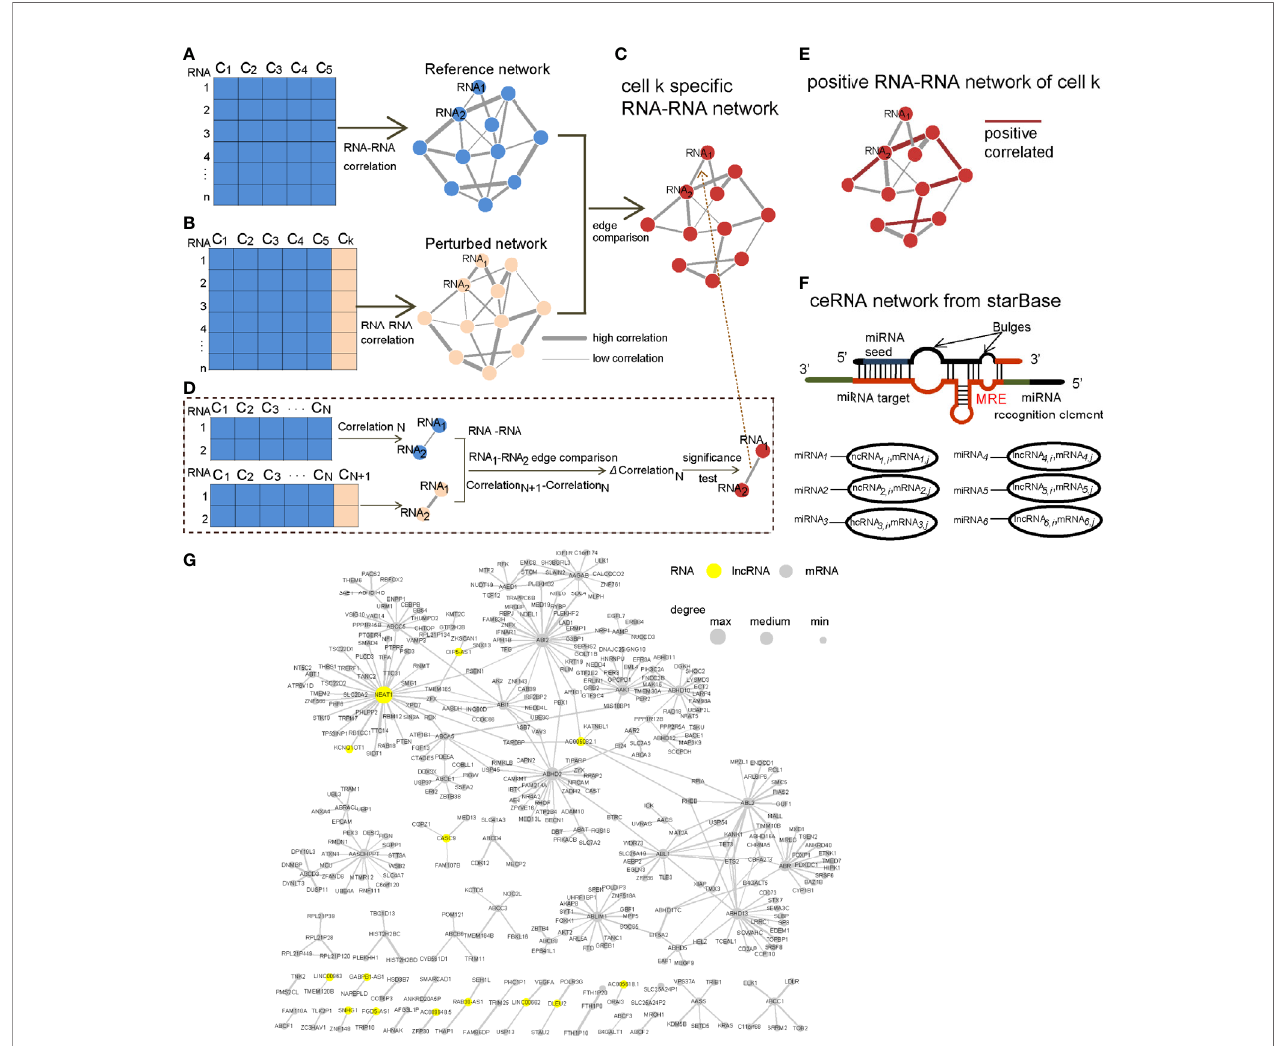
FIGURE 1 | Work fl ow of constructing the CCN. (A) Reference cells were selected, and the corresponding RCN was constructed and referred to as “ Reference network ” . (B) One cell k was added to the reference cells, and the corresponding RCN was constructed and referred to as the “ Perturbed network ” . (C) Edges were compared between the “ Reference network ” and “ Perturbed network ” to obtain a cell k-speci fi c RNA – RNA network. (D) One edge composing of two RNAs was compared and tested for its signi fi cance level, based on the differential correlation ( D Correlation N ). (E) Only the positive edges in the cell k-speci fi c RNA – RNA network were candidate edges in the CCN. (F) We downloaded the ceRNA network from starBase. (G) An example of a CCN. The yellow nodes represent lncRNAs, and node size is proportional to its degree in the